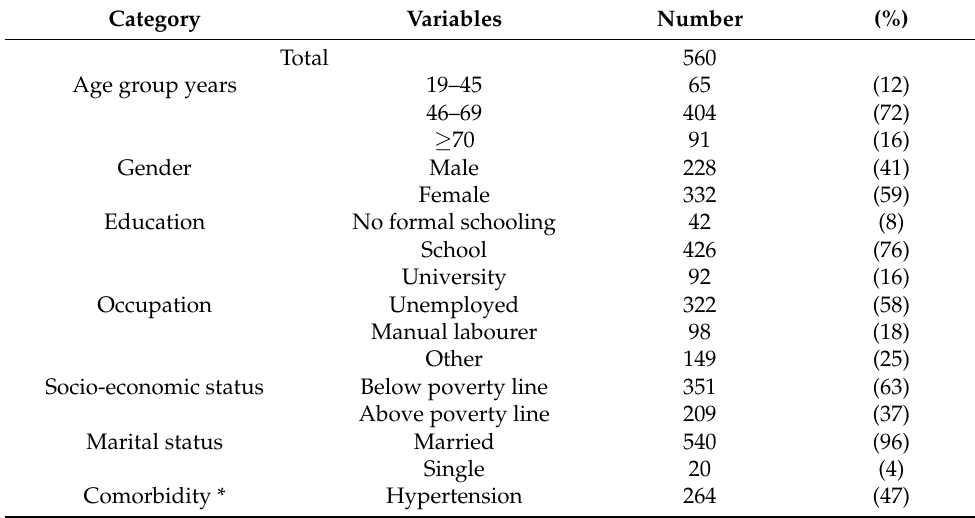
Table 1. Socio-demographic and clinical characteristics in persons with diabetes mellitus attending primary health care facilities, Kerala, India,